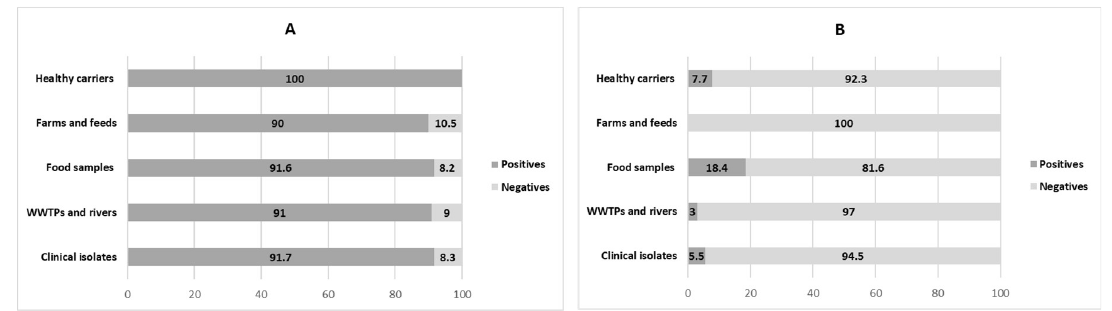
Figure 1. Prevalence (percentages) and distribution of ( A )class 1 ( intI1) and ( B ) class 2 ( intI2) integrons